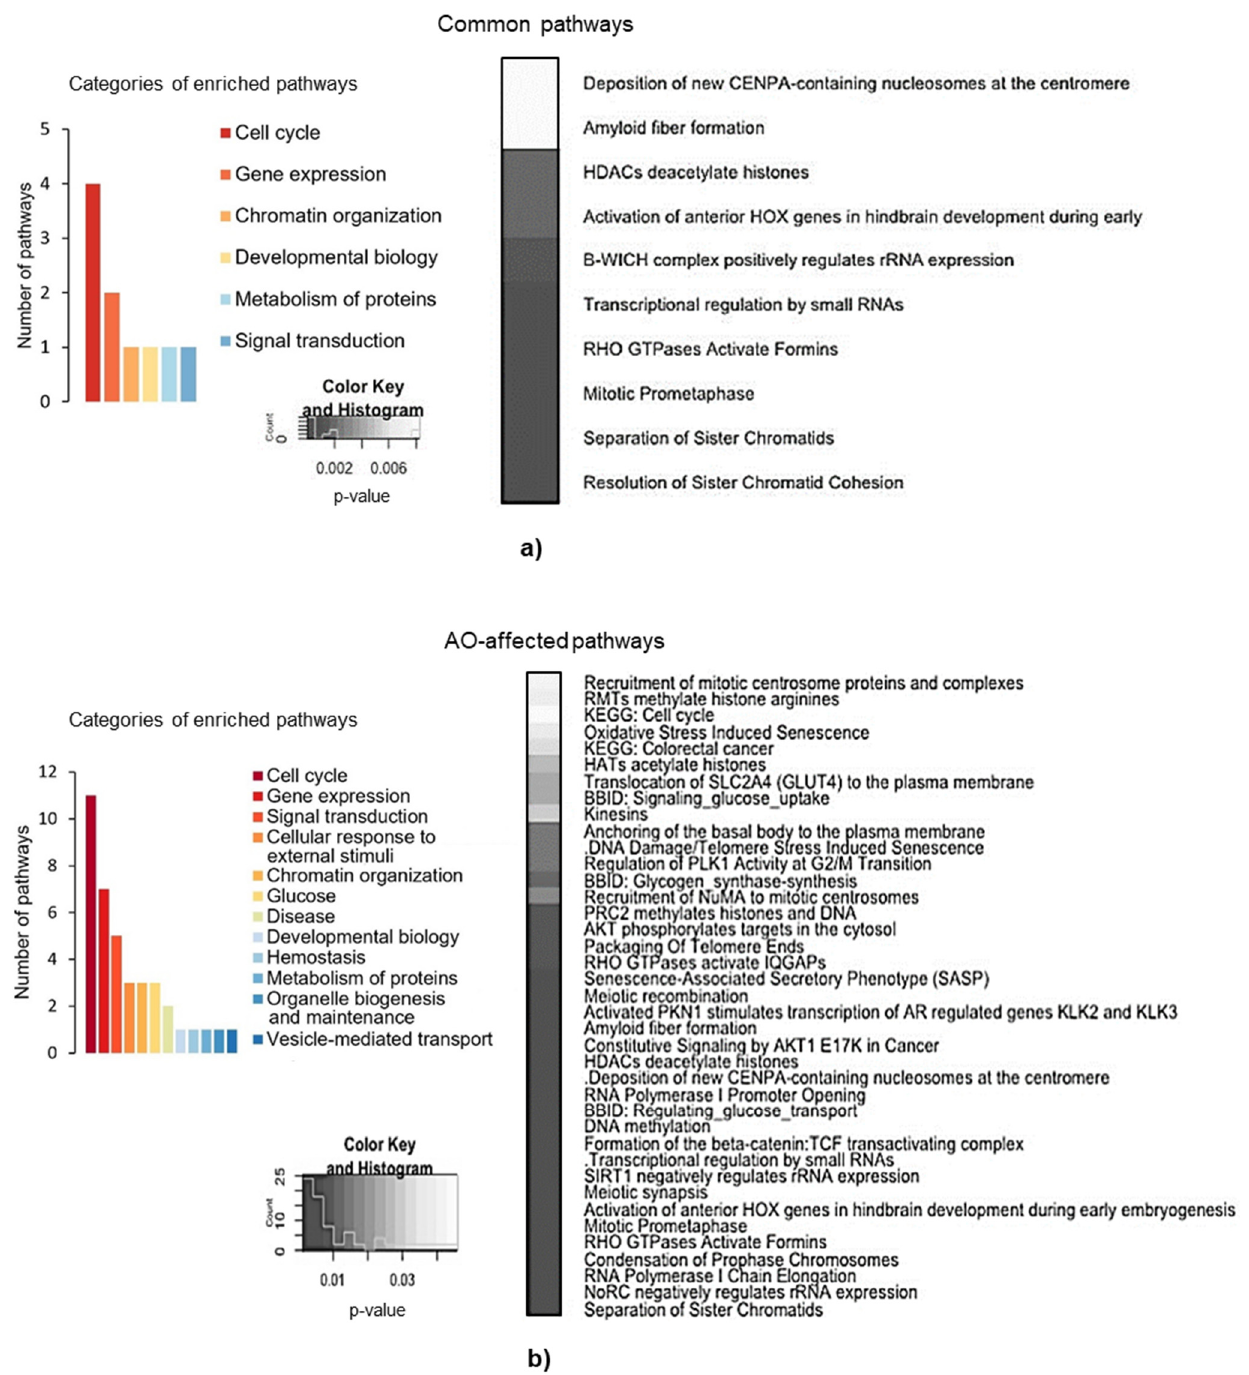
Figure 4. Common pathways enriched after Tempol and resveratrol treatments: ( a ) List of the core categories (left panel) to which the common pathways (right panel) significantly enriched by both antioxidants belong ( p -value ≤ 0.05, Benjamini and Hochberg analysis); ( b ) list of the core categories (left panel) to which AO-affected pathways (right panel) belong. AO-affected pathways is a set of pathways significantly ( p -value ≤ 0.05, Benjamini and Hochberg analysis) enriched by genes that are up- or down-regulated with a fold change greater than 1.5 by both AOs (such genes are shown as intersections of diagrams in Figure 3a,b).